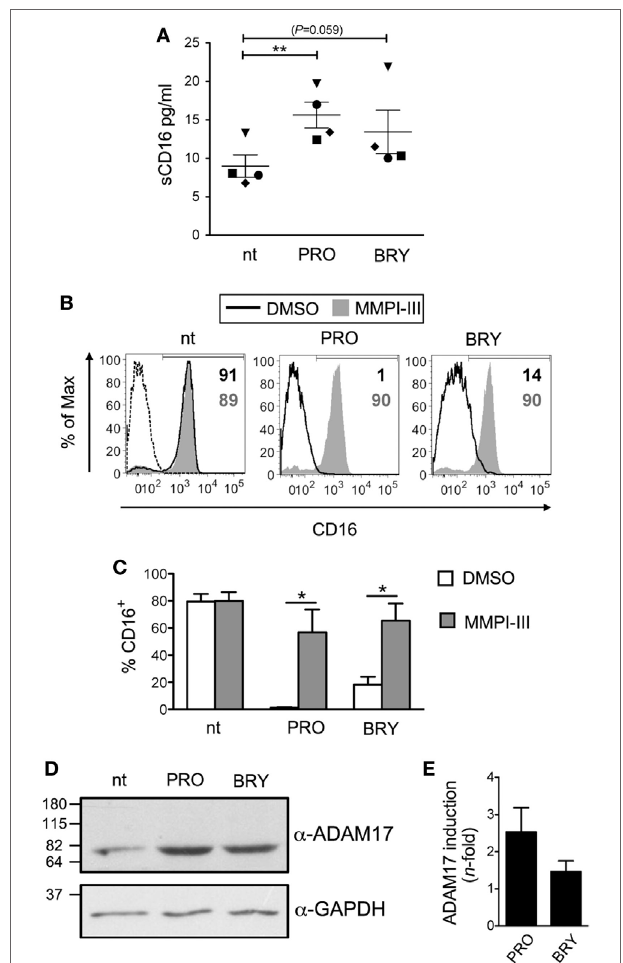
FigUre 2 | CD16 is shed from natural killer (NK) cells upon exposure to prostratin (PRO) or bryostatin-1 (BRY). (a) Soluble CD16 (sCD16) was measured in the media of NK cells after 18 h culture without [not treated (nt)] or with the addition of 1 µM PRO or 10 nM BRY. Each symbol represents one donor ( n = 4). The mean ± SEM is reported. (B,c) NK cells were pre-exposed to 25 µM MMPI-III inhibitor or equivalent amounts of DMSO for 1 h, then 1 µM PRO or 10 nM BRY were added or not for 18 h and finally analyzed for cell-surface CD16 expression. (B) Histograms show CD16 signal on nt, PRO- and BRY-treated cells either exposed to MMPI-III (filled gray histograms) or to DMSO (solid line) in one representative experiment. Signal of control IgG (dashed line) and the frequency of CD16 + cells (gray or black when MMPI-III or DMSO are present, respectively) are also shown. (c) Bars represent mean ± SEM ( n = 3). (D) The catalytic 80 kDa form of ADAM17 (top) and GAPDH as internal control (bottom) were detected by western blotting analysis of total protein extracts of nt, PRO- and BRY-treated NK cells. Molecular mass standards are indicated (kDa). (e) Quantification of ADA17 induction by PRO and BRY relative to nt condition. The ADA17 signal normalized for GAPDH signal was quantified and divided for the value obtained in the nt sample. Data show mean ± SEM of three independent experiments like the one shown in (D) . * P < 0.05 and ** P < 0.01 by paired t